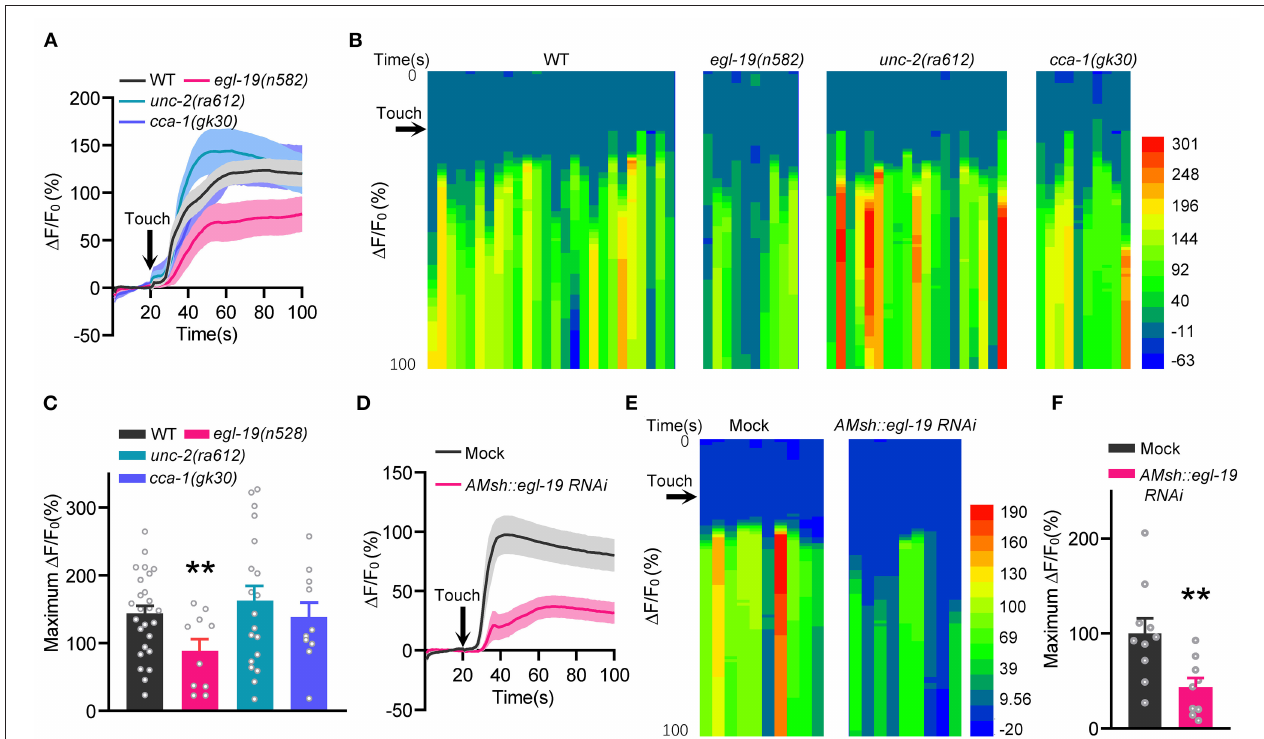
FIGURE 2 | EGL-19 is essential for touch-evoked Ca 2 + Increases in AMsh Glia. (A–C) Nose touch (2Hz 20 µ m displacement for 5s) -evoked calcium variations of the AMsh glia in wild type, egl-19(n582) mutants, unc-2(ra612) mutants, and cca-1(gk30) mutants. (A) Calcium responses. (B) Heat map of calcium responses. (C) Maximum 1 F/F 0 changes. Touch was performed toward the nose tip of the animals through a piezoelectric actuator, which can transform one volt pulse to 4.5 µ m mechanical stimulation, wild type (ST1071), n = 26; egl-19(n582) (ST2889) , n = 10; unc-2(ra612) (ST2990) , n = 19; cca-1(gk30) (ST2991) , n = 10; unpaired t -test. (D–F) Specific knockdown of egl-19 in AMsh glia led to defective AMsh glial calcium increases in response to nose touch. (D) Calcium responses. (E) Heat map of calcium responses. (F) Maximum 1 F/F 0 changes. Mock (ST2674), n = 10; AMsh egl-19 RNAi (ST2729), n = 9; unpaired t -test. Error bars represent SEM. ** p <